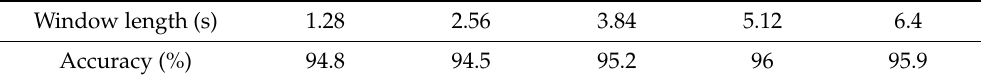
Table 3. The accuracy of the classifier under different window lengths in the PAMAP2 data set.